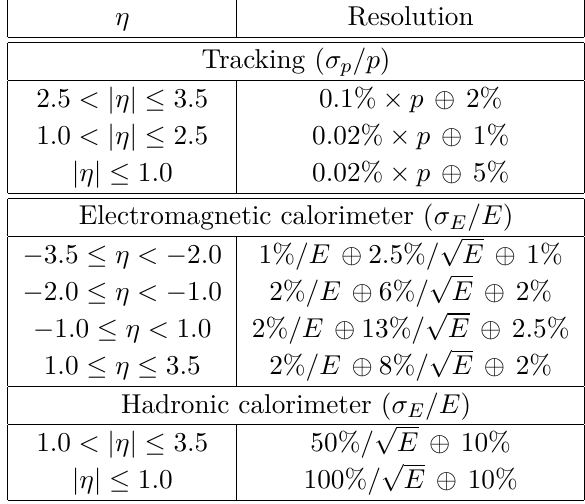
Table 1 . Angular coverage, tracking momentum resolution, and calorimeter resolutions of the EIC detector used in our analysis. These parameters are based on [4,